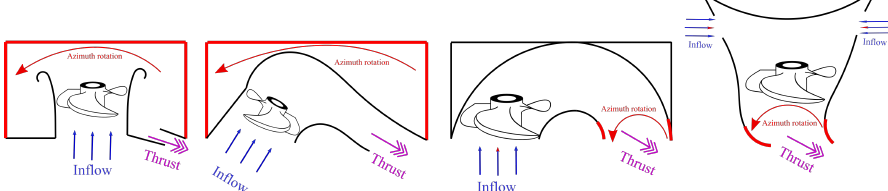
Figure 3. Schematic description of the industrial products. Left to right: Schottel SPJ [28], Veth Compact Jet [27], Jastram Azimuth Grid Thruster [29], and Tees T3s Vertical Shaft Unit